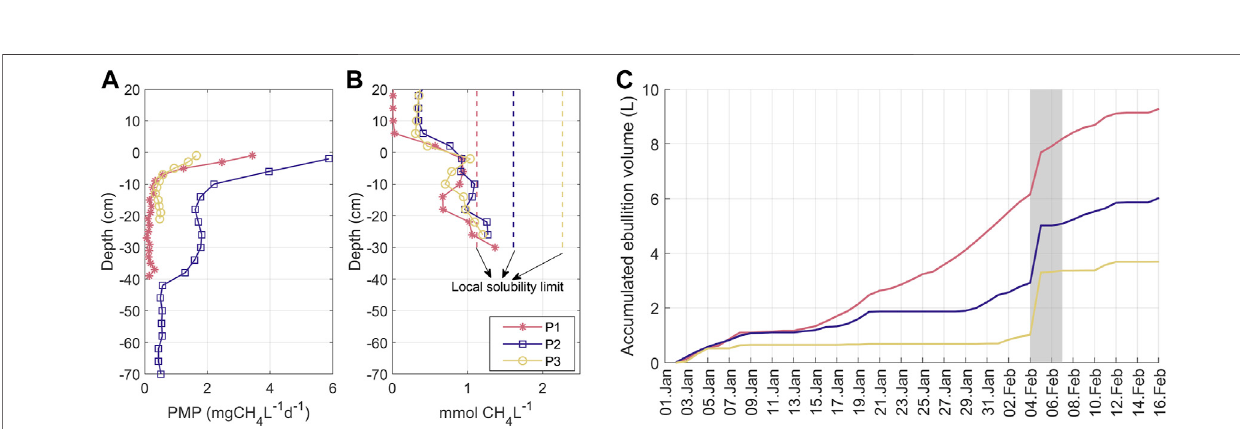
Frontiers in Environmental Science |